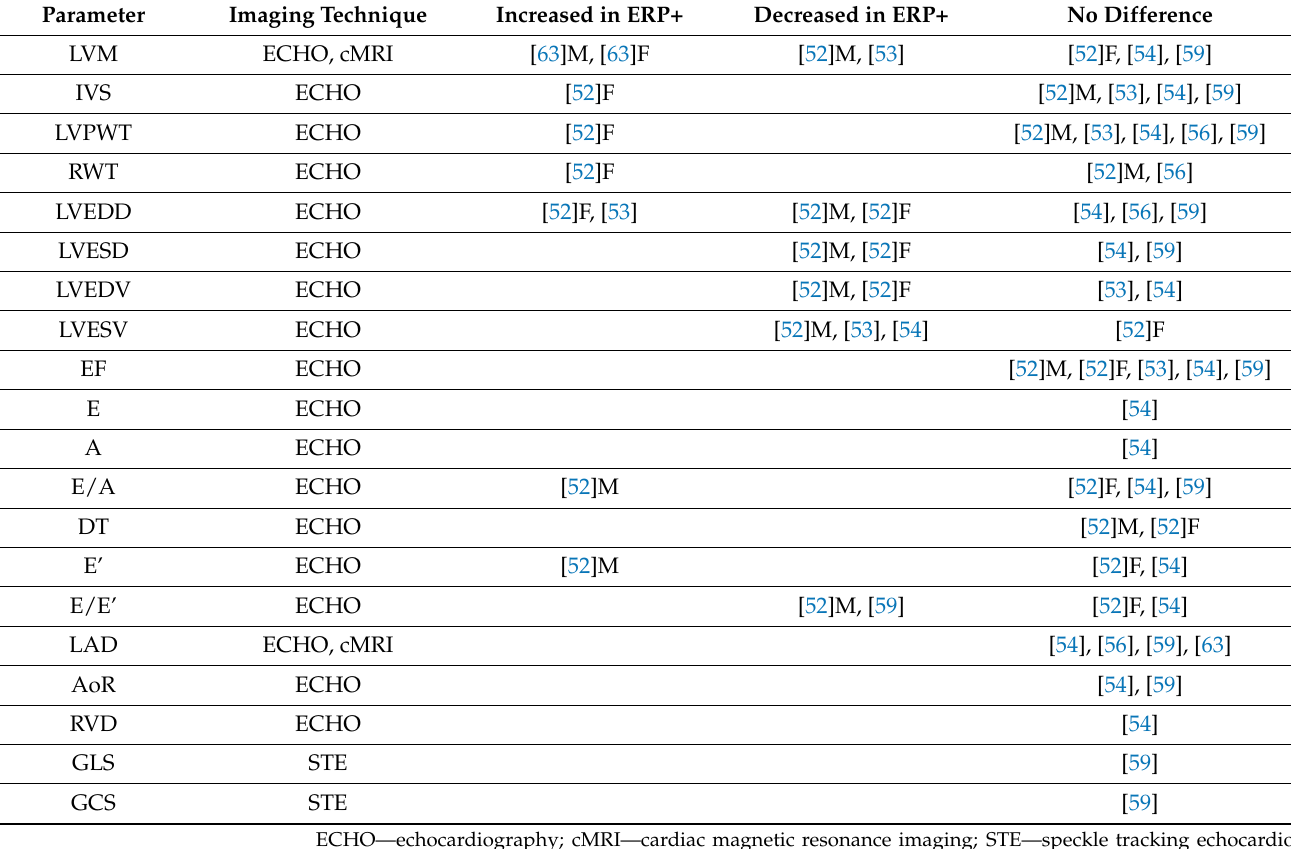
Table 5. The main cardiac morphological and functional parameters investigated in different studies performed on the general population. The differences between ERP+ and ERP- individuals. The reference of the study is indicated in the square bracket, the M and F after the bracket denote the male and female